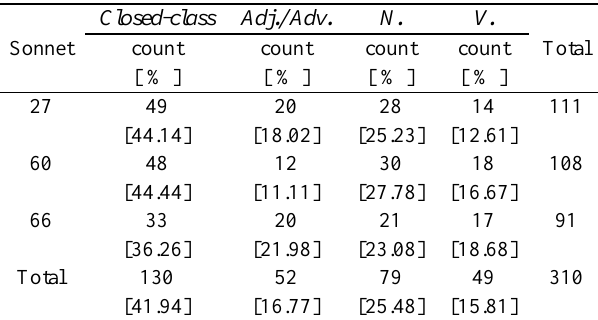
Table 1 . Number of Words per Category within Each Sonnet and within all Three Sonnets Closed-class Adj./ Sonnet